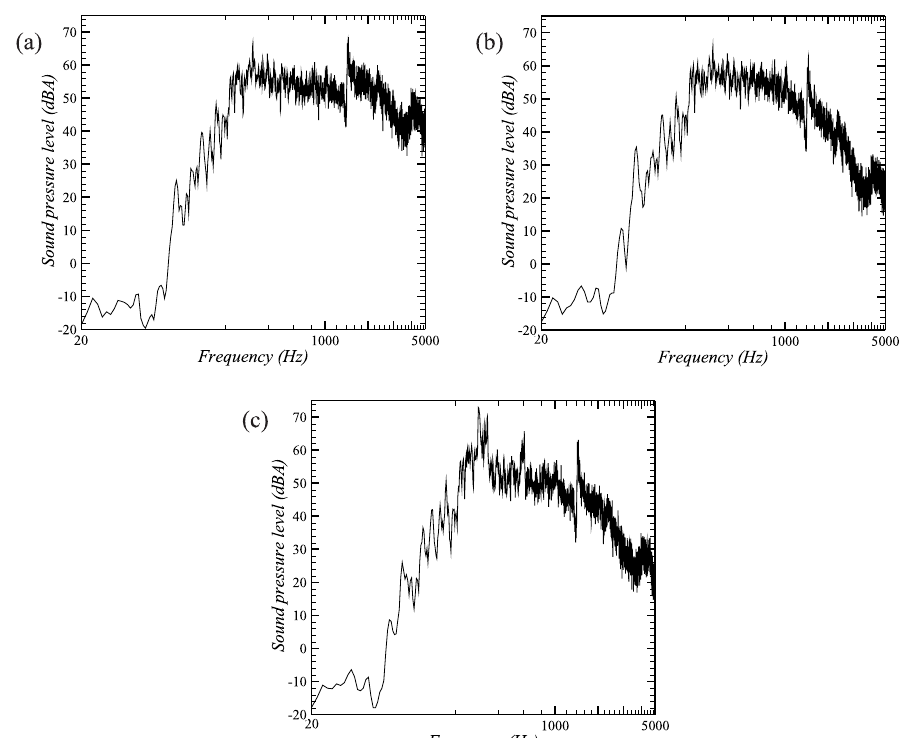
Figure A1. Noise spectrum. ( a ) White noise ( b ) traffic noise ( c ) construction noise. Results are presented using narrow frequency band with step of 2 Hz in log